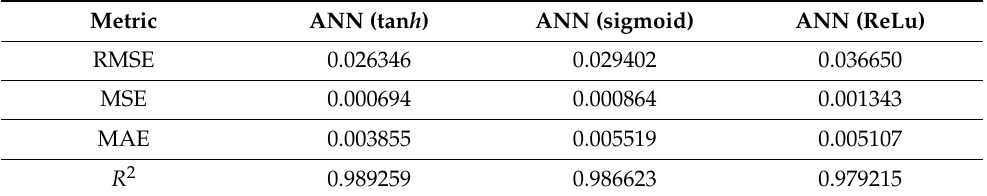
Figure 14. 2D contour and the 3D surface of hyperparameters tuning for ( a ) DT, and ( b ) RF for the target k rwp . Table 10. Performance evaluation metrics of the ANN model with different activation functions for the target k rwp